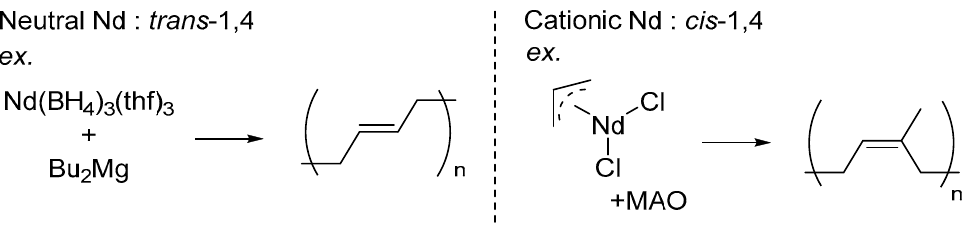
Figure 1. Examples of living butadiene/isoprene polymerization using simple neodymium catalysts. MAO: methylaluminoxane.